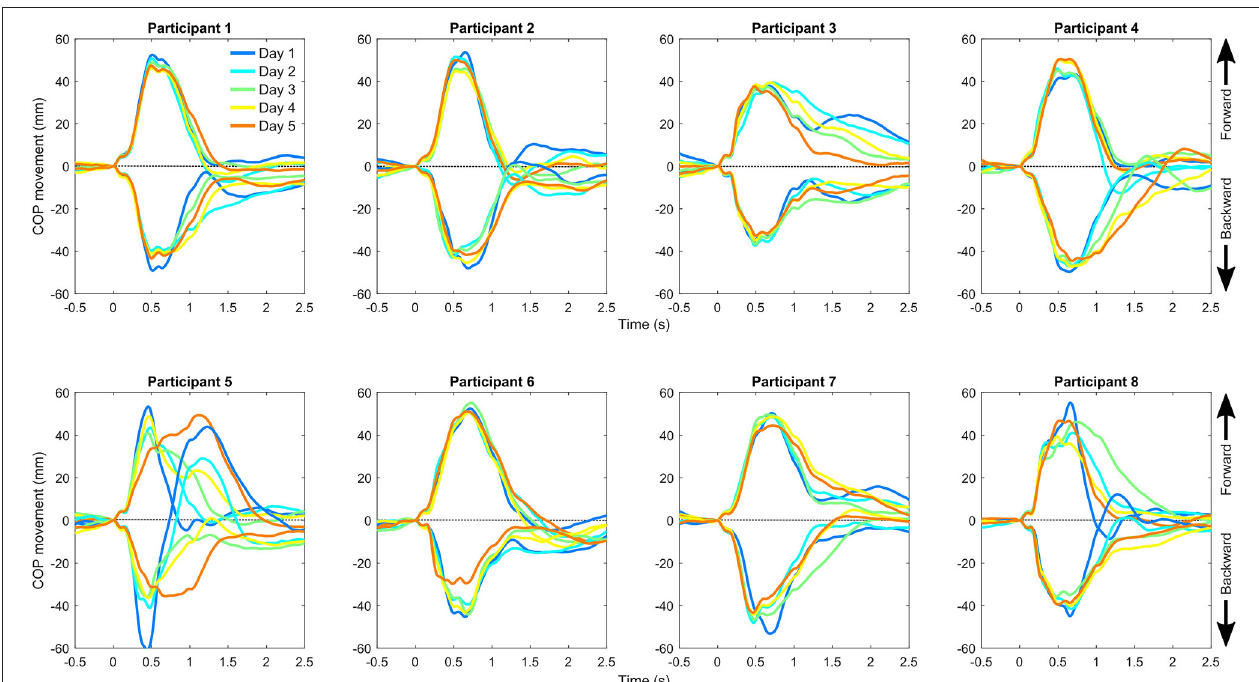
FIGURE 3 | Center of pressure (COP) movement relative to the belt in the slow backward and forward perturbation protocols separately for each participant and measurement day. The positive direction of the center of pressure movement is forward (direction of gaze) and occurs in response to backward perturbation of the belt.